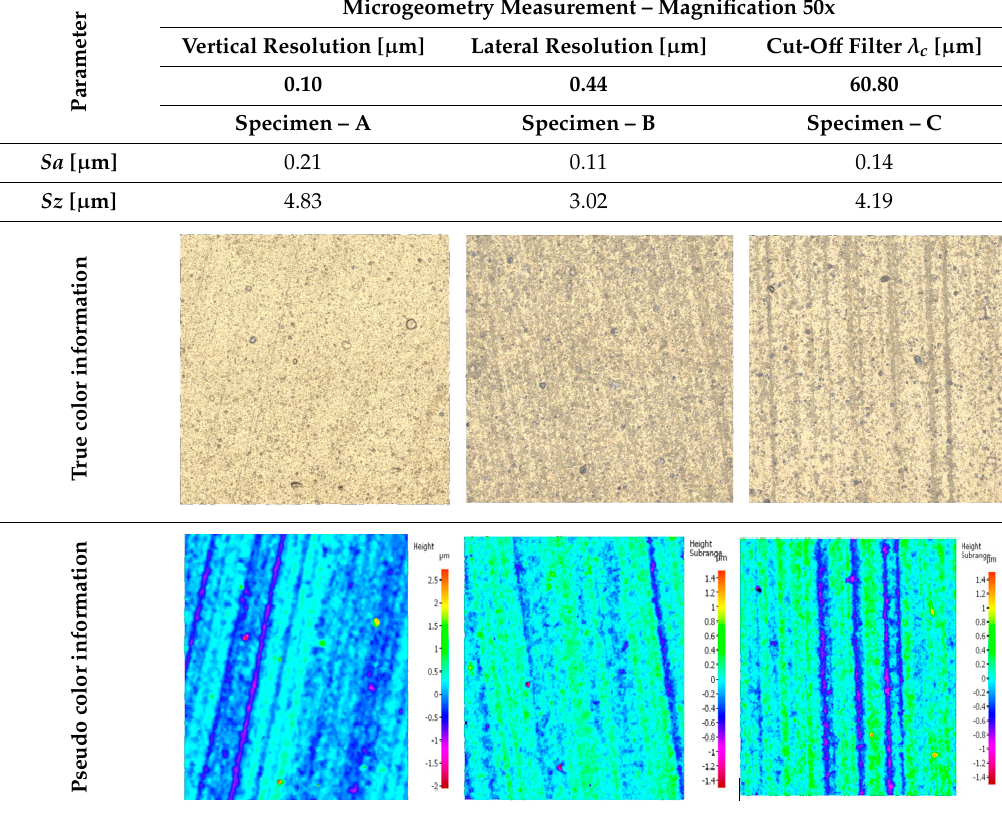
Table 5. Occurrence of droplets before and after cutting edge preparation.